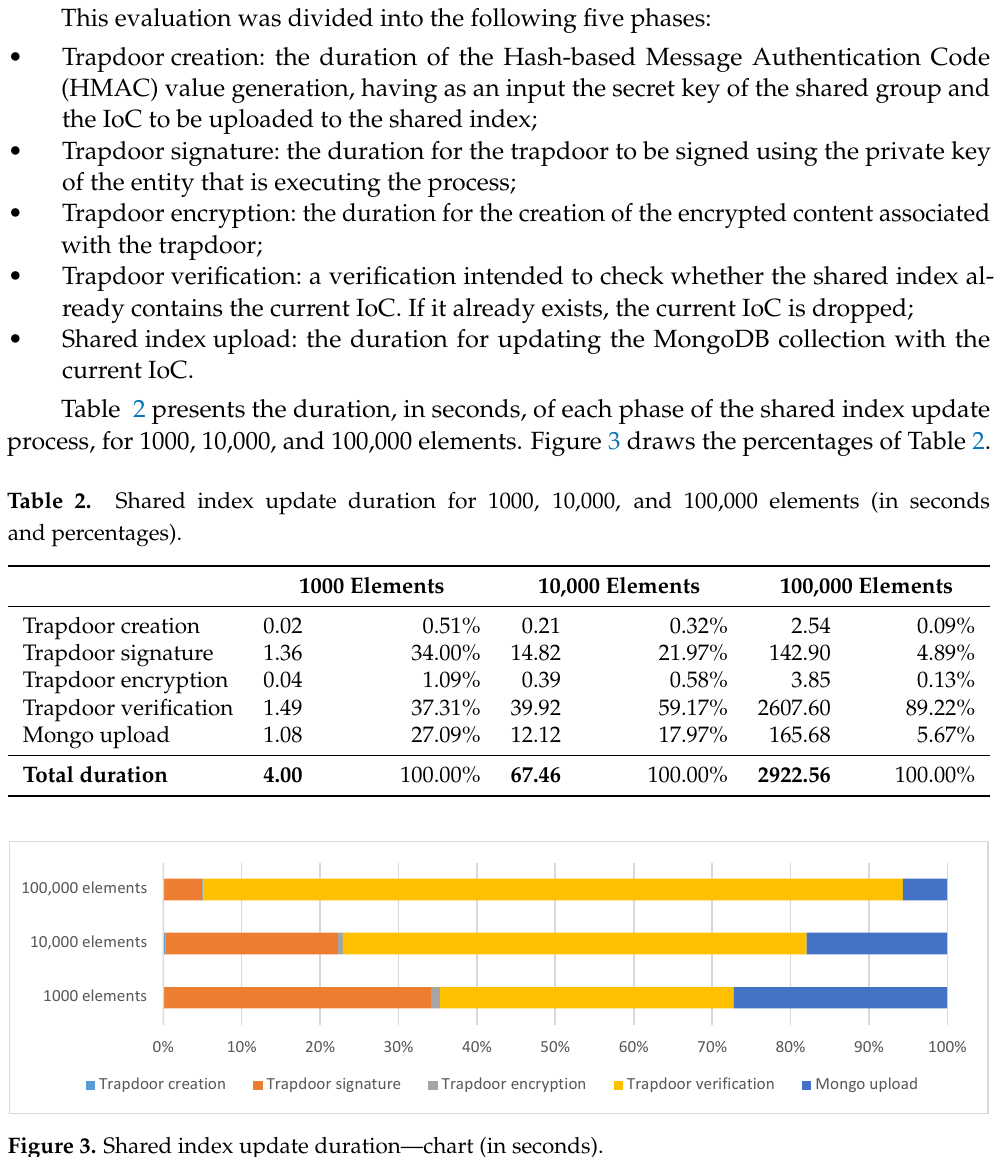
Figure 3. Shared index update duration—chart (in